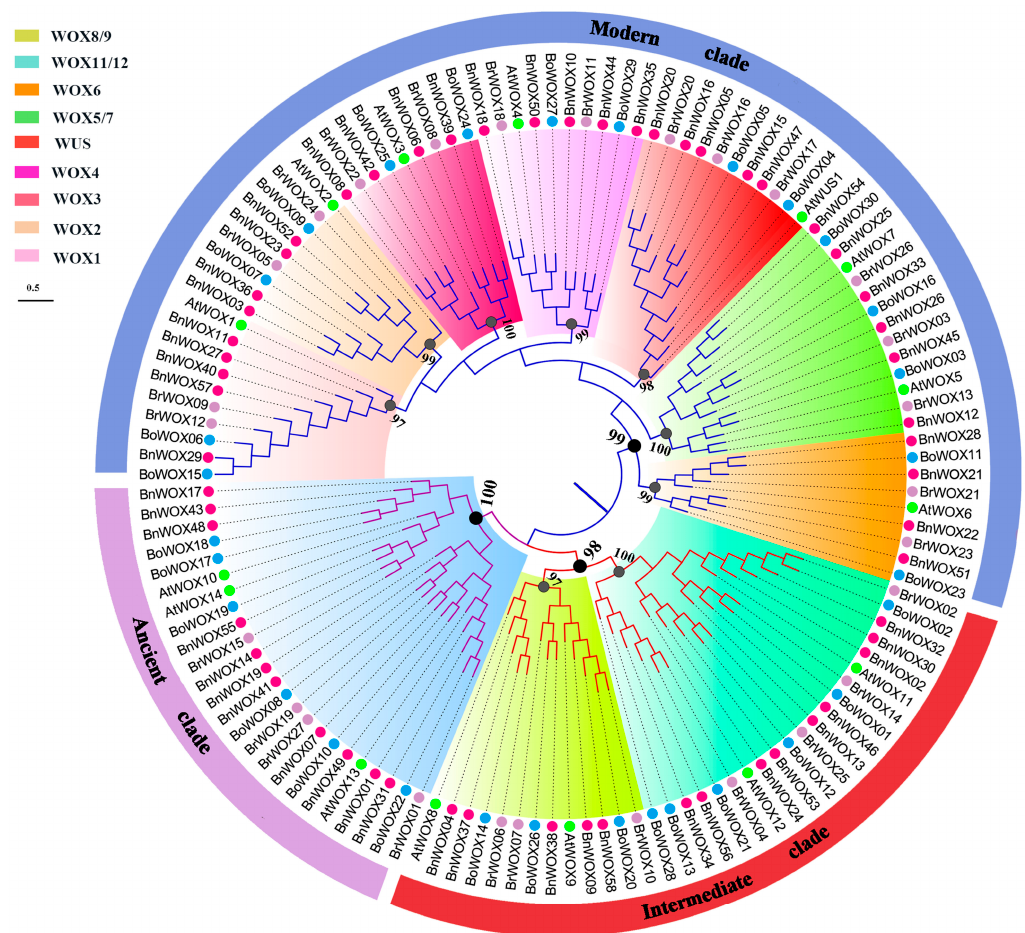
Figure 1. Phylogenetic relationships of 130 WOX genes. The phylogenetic tree was generated from the alignment of 130 WOX protein homeodomain sequences, with 1000 bootstrap replicates. The WOX genes from Arabidopsis (At: 15), B. rapa (Br: 27), B. oleracea (Bo: 30) and B. napus (Bn: 58) are shown as green, purple, blue and red dots, respectively. The outer circle represents three clades, marked in purple, blue and brown colors. Nine subclades were identified and are marked in different background colors; bootstrap values are shown near the nodes.